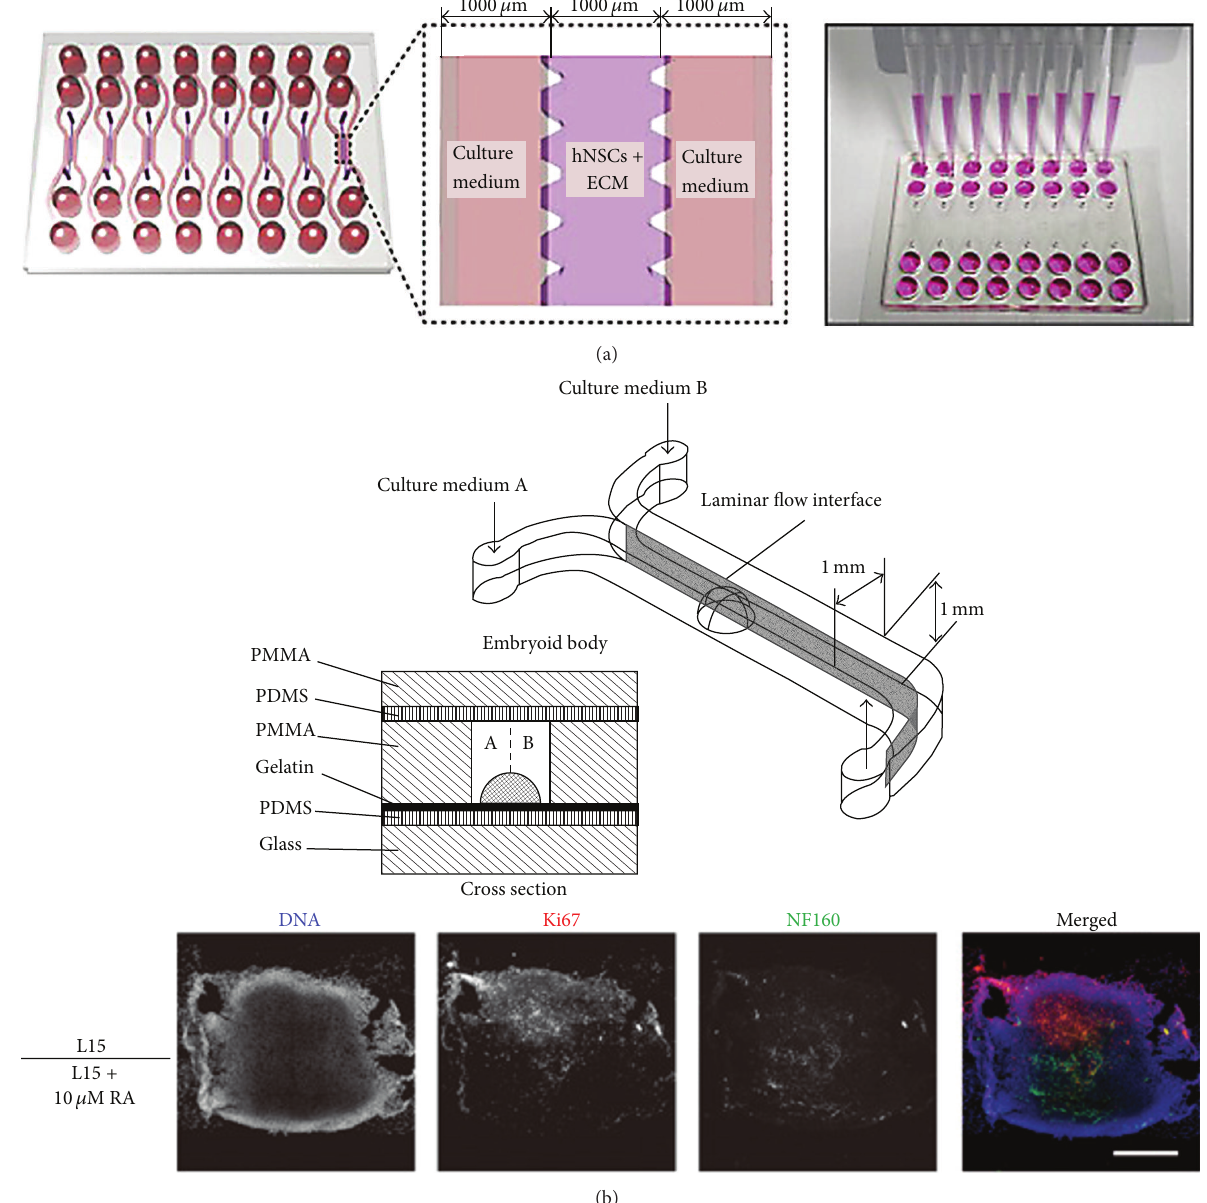
Figure 5: (a) Schematic illustration of niche-like microsystem. The central culture chamber was seeded with hNSCs with hydrogel solutions and the two sides of channels were filled with culture medium. Therefore, the needed molecules were provided to the hNSCs through the diffusion from the side channels. (b) Schematic representation of microfluidic system for EB differentiation. Two different solutions (one with growth factor) were injected to the Y-channel. The advection became more dominant than diffusion preventing growth of concentration gradient profile; therefore, the differentiation was developed only one side of the EB. Image analysis confirmed the influence of 10 𝜇 M RA (retinoic